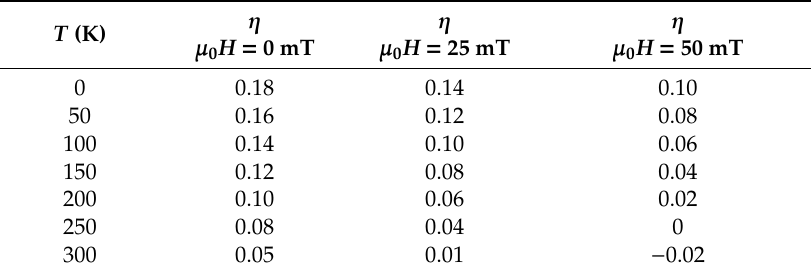
Table 3. Calculated values of η used in the numerical calculations.